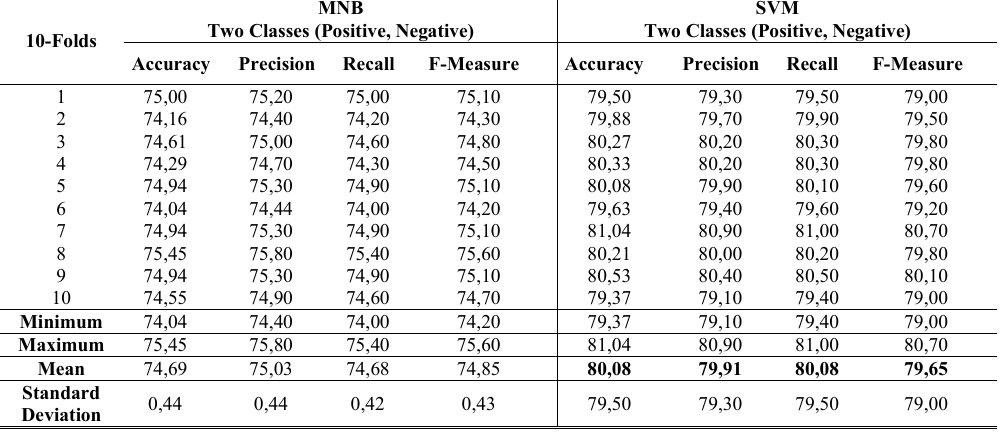
TABLE 3 C LASSIFICATION R ESULTS OF T HE E CONOMIC A SPECT USING TWO CLASSES